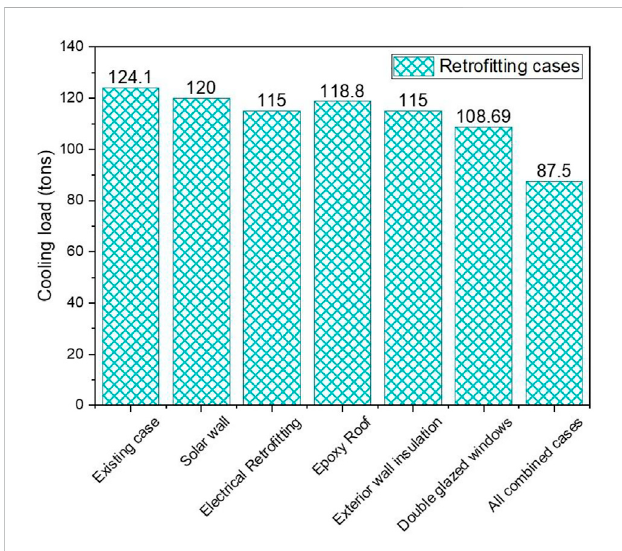
FIGURE 5 Reduction in cooling loads through various retro fi tting measures.